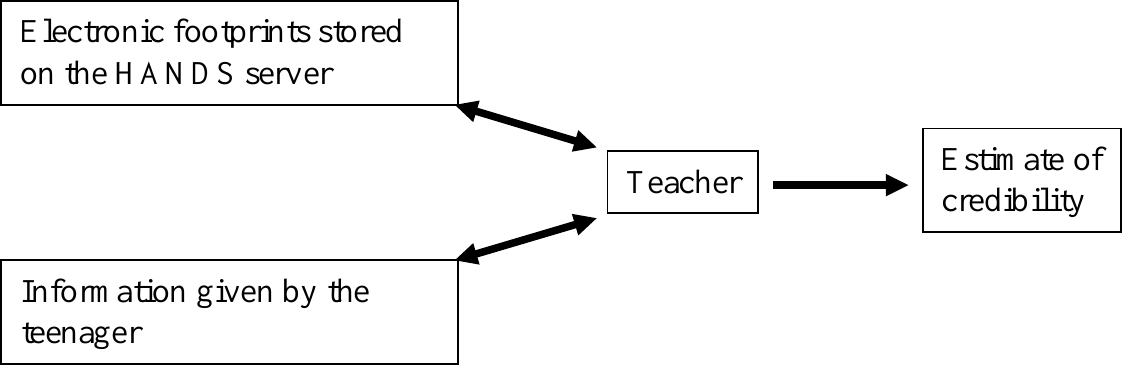
Figure 3 . The teacher has to estimate how credible the teenager finds the particular component in his individual HANDS toolbox. The degree of credibility is an estimate of how helpful the component is according to the evaluation of the teenager. In addition to this, it is useful to have an estimate of how helpful the component could be according to the evaluation of the